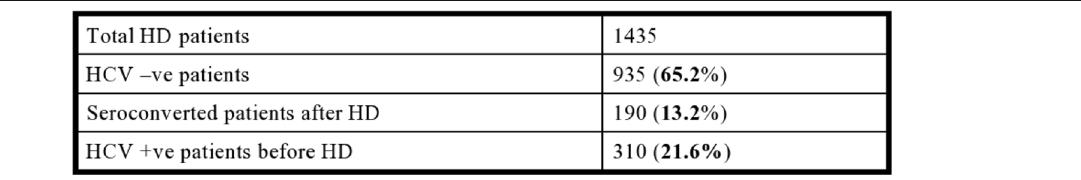
Table 1 Screening of HD patients for HCV